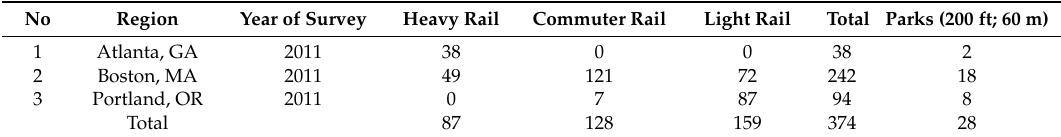
Table 1. Study regions and transit stations.